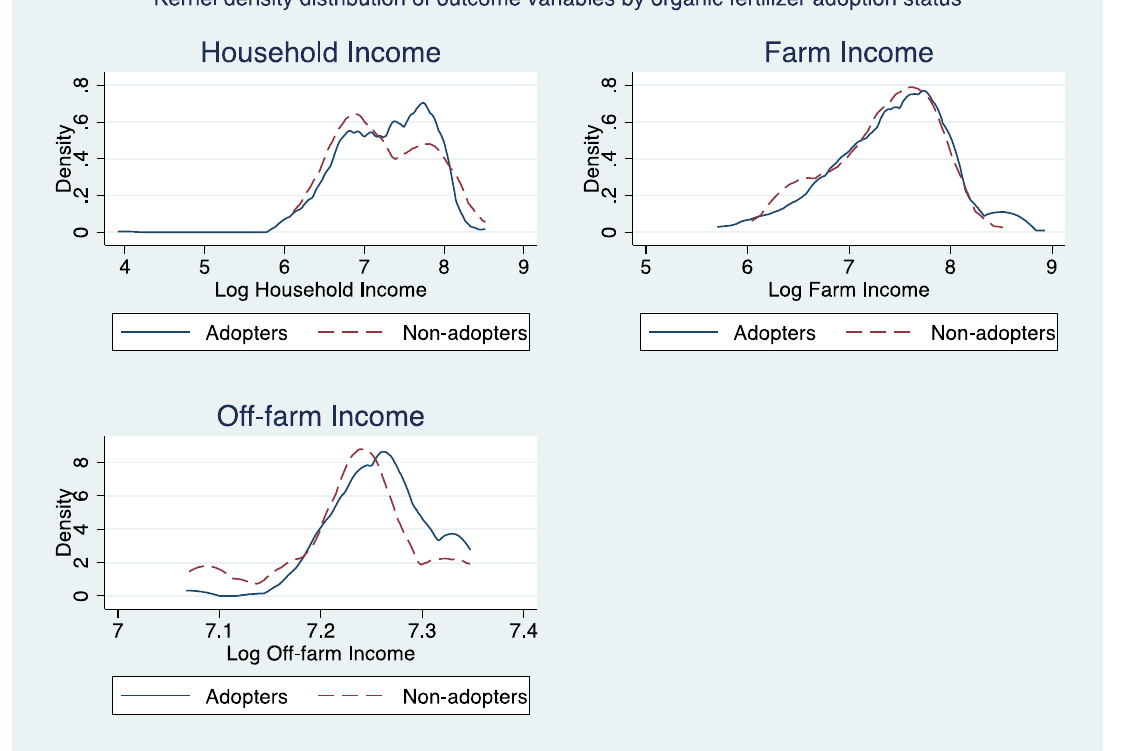
Figure 5. Kernel density distribution of outcome variables by organic fertilizer adoption.